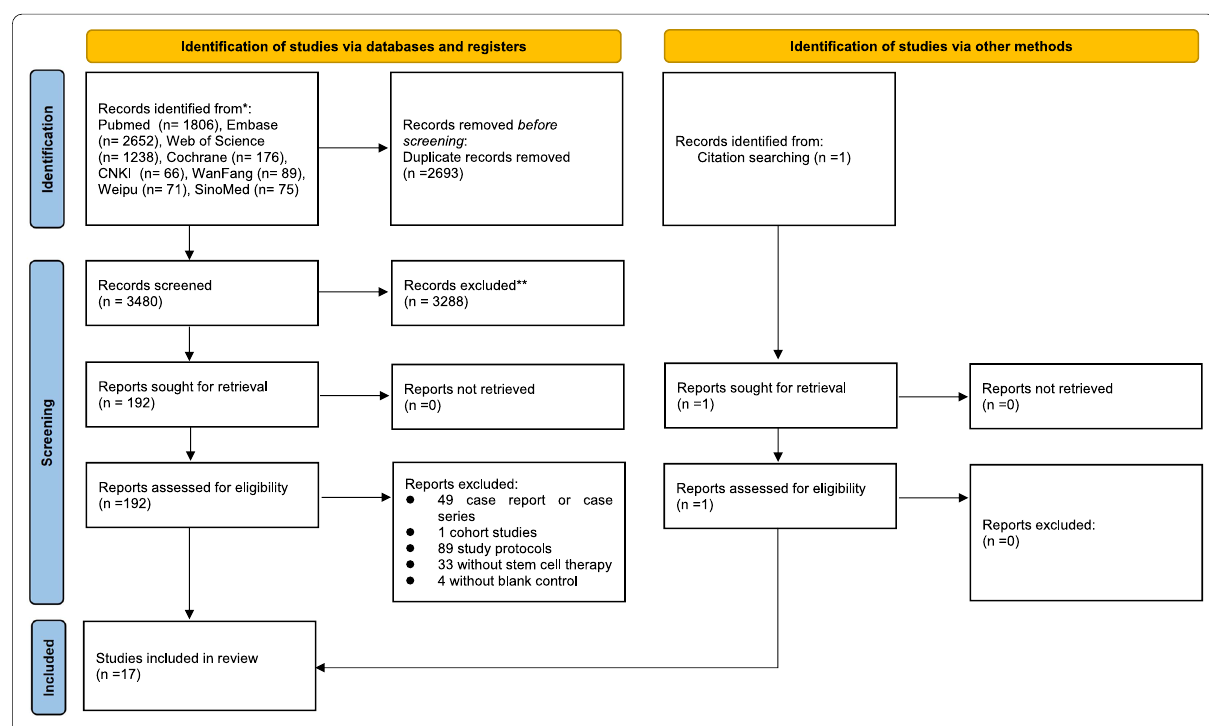
Fig. 1 PRISMA flow diagram. Summary of evidence search and study